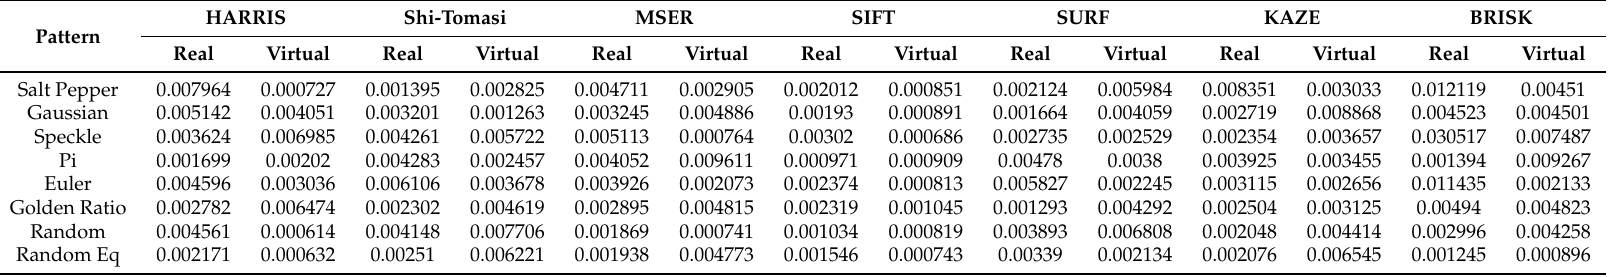
Table 2. The standard deviation calculated for the dense point clouds of planar surface reconstruction while using the best fit